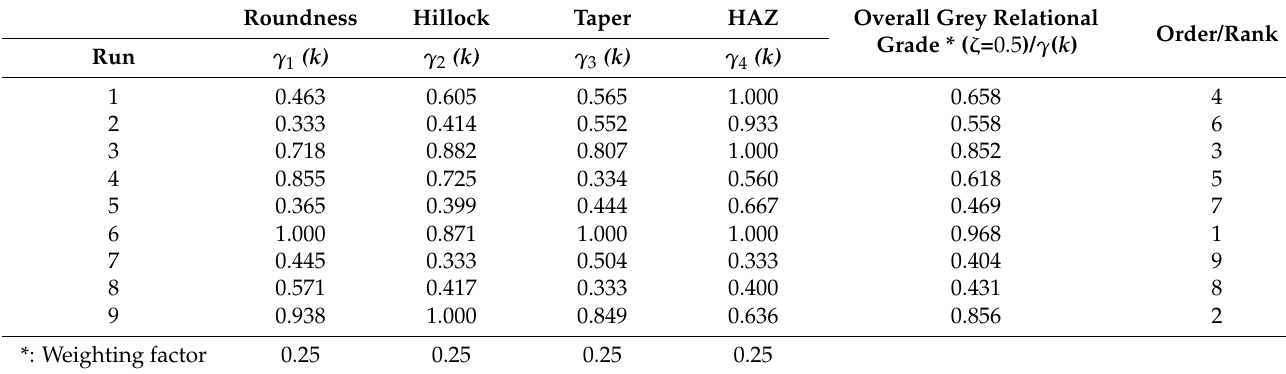
Table 7. Calculated results of grey relational analysis with equal weighting factors.